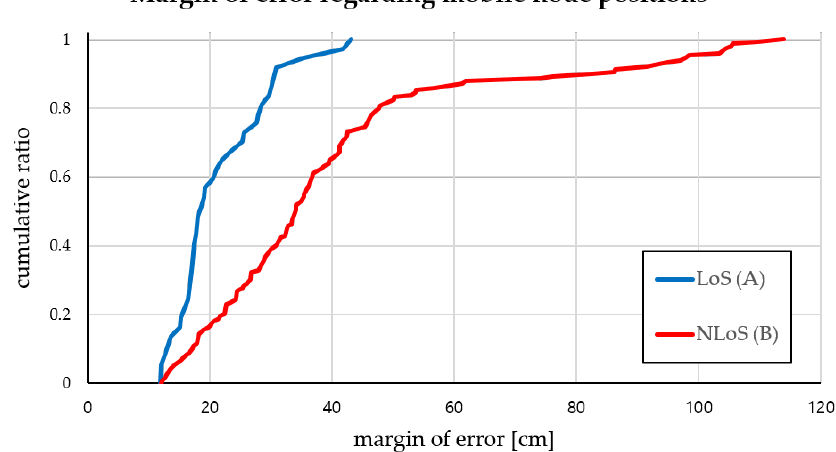
Figure 11. Margin of error regarding actual mobile node positions shown in both LoS and NLoS